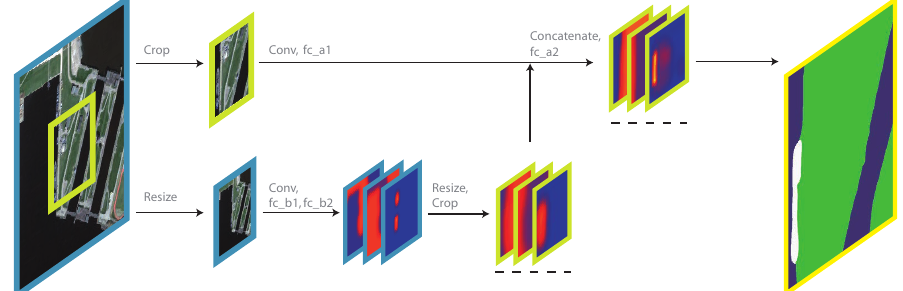
Figure 3. An illustration of the proposed network. The texts on the arrowed lines specify the layers the data go through to produce the displayed results. The color of the outline (blue and yellow) of each result marks the corresponding input area it represents for the sake of clarity. The results that are directly connected to loss layers are underlined with dashed